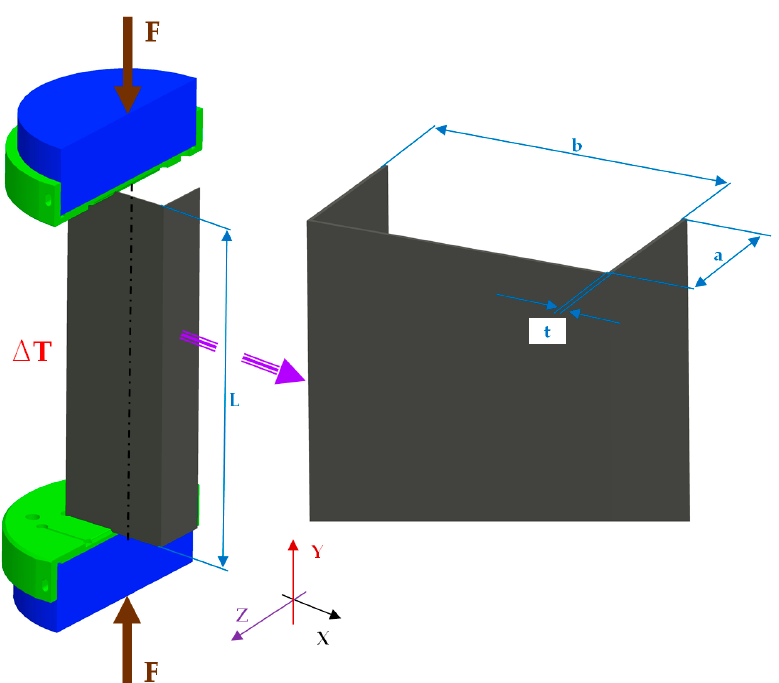
Figure 1. The object of the study.